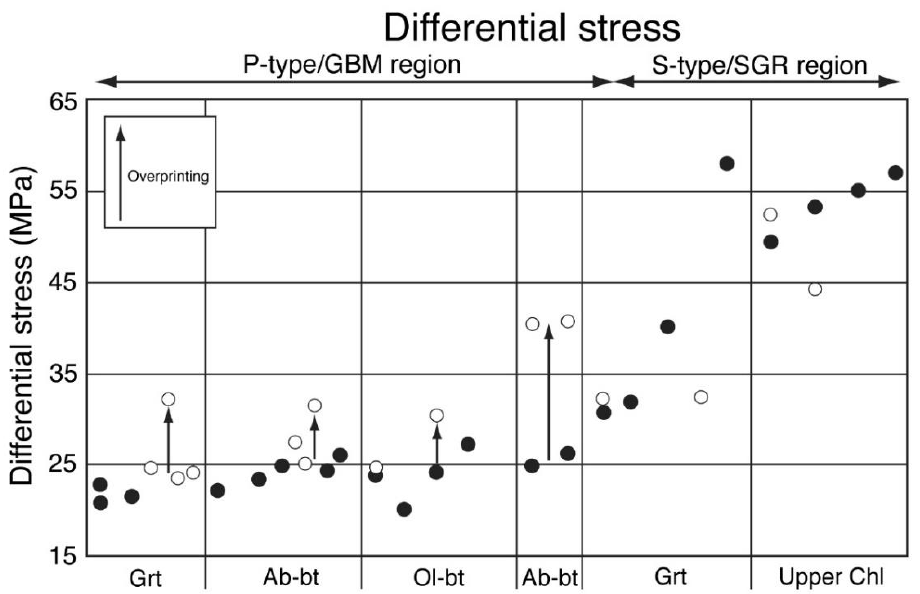
Figure 6. Plot of calculated flow stress (MPa) along the Asemi-Saruta-Dozan River traverse, using the piezometer of [72], where the empirical constants, A and x (see text), are 676 and 0.68, respectively. Solid and open circles are data after [46,55], respectively (also see Figure 3a). For overprinting shown by arrows, see the captions of Figure 3a and text for explanations. See text for abbreviations of each of the peak-metamorphic zones.